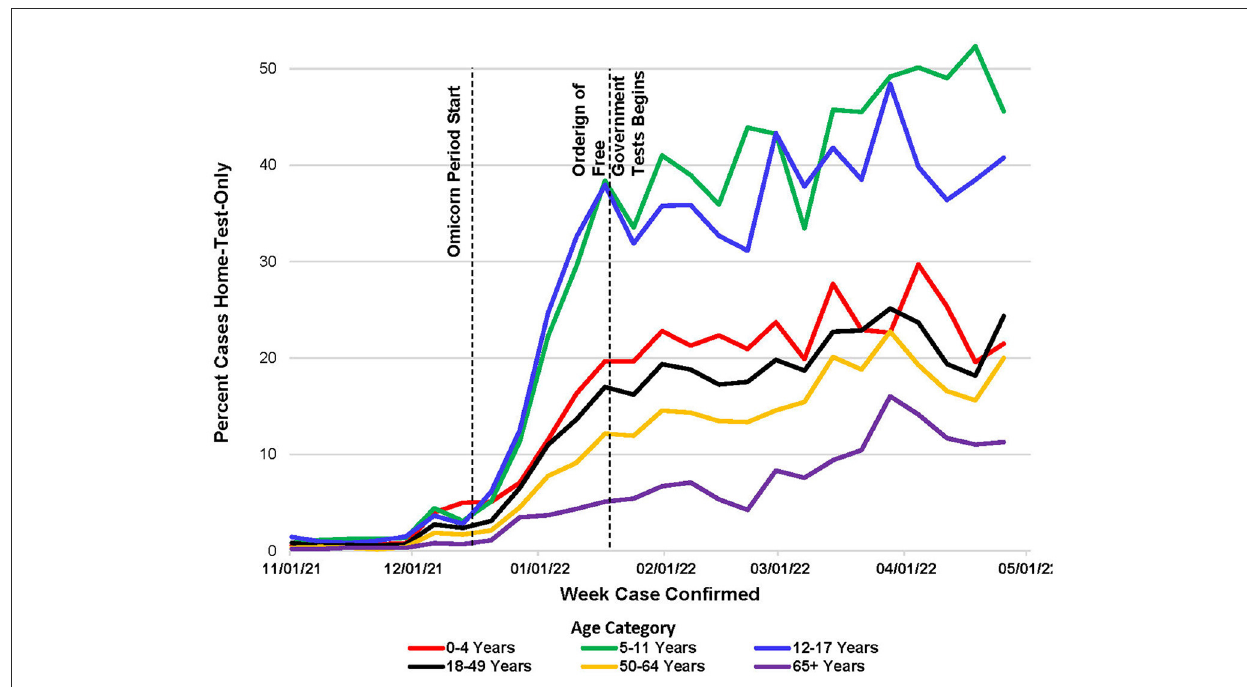
FIGURE2 Percent of cases via home-tests-only (of all cases), by week and age category, November 2021–April 2022.